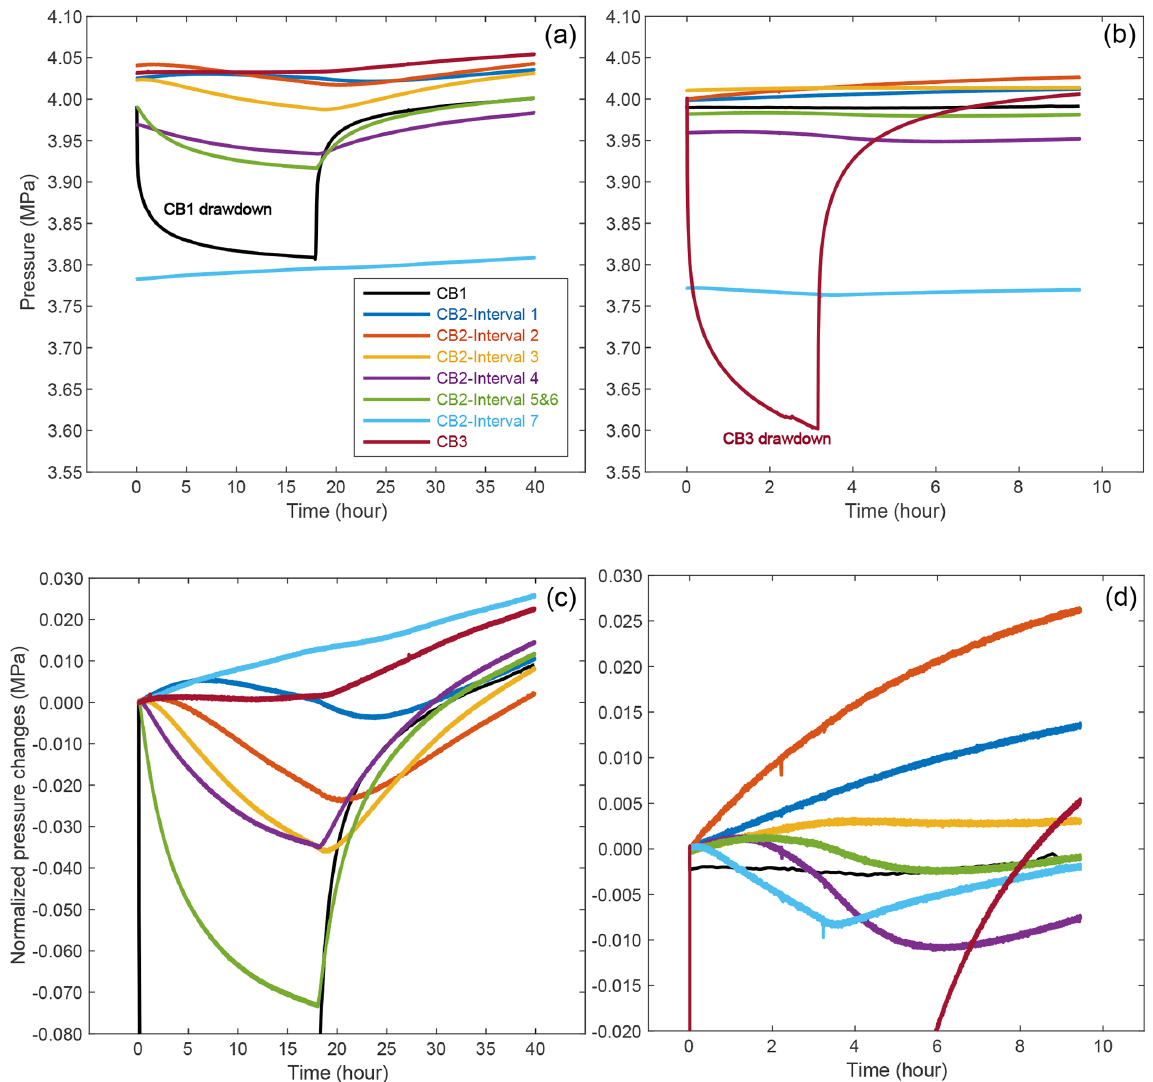
Figure 10. The pressure response of boreholes/intervals to the drawdown in CB1 (a, c) and CB3 (b, d) . The upper and lower row present the absolute and relative pressure (changes),